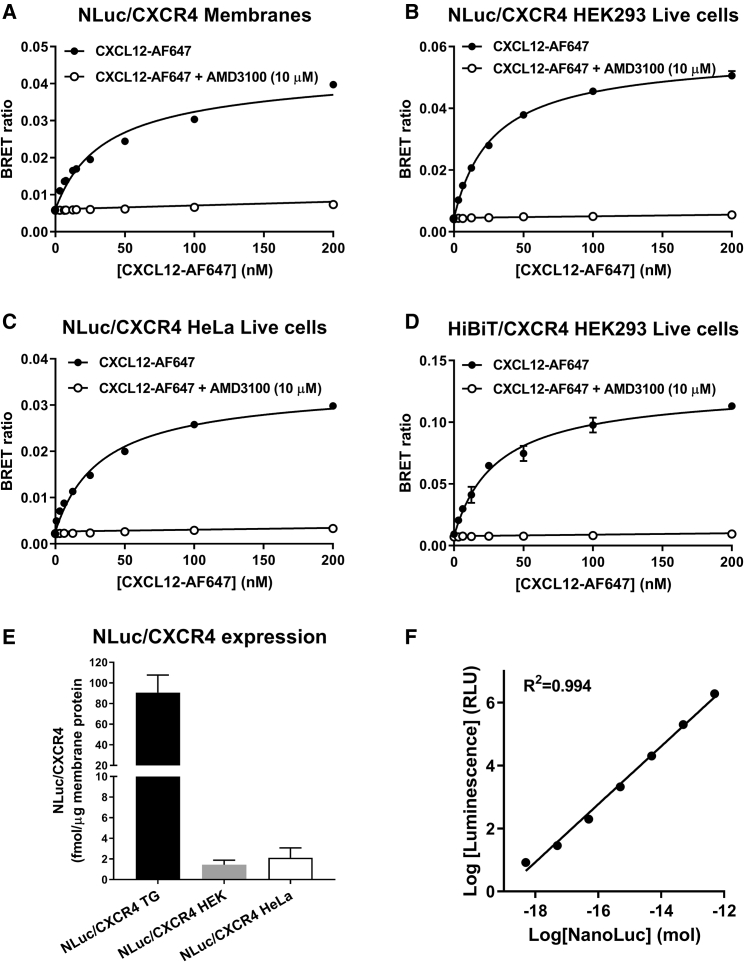
Determination of the Binding Affinity of CXCL12-AF647 at NLuc/CXCR4(A–D) NanoBRET saturation ligand binding curves obtained in (A) membrane preparations from HEK293 cells exogenously expressing NLuc/CXCR4 (B) live HEK293 cells expressing genome-edited NLuc/CXCR4 (C) live HeLa cells expressing genome-edited NLuc/CXCR4 or (D) live HEK293 cells expressing genome-edited HiBiT/CXCR4 complemented with LgBiT. Cells or membranes were incubated with increasing concentrations of CXCL12-AF647 in the absence (black circles) or presence (white circles) of AMD3100 (10 μM) for 1 h at 37°C. Data shown are mean ± SEM and are representative of three or four independent experiments performed in duplicate for (A and B) and (C and D), respectively.(E) Quantification of NLuc/CXCR4 expression by linear regression (F), as described in the STAR Methods, using membrane preparations made from HEK293 cells exogenously expressing NLuc/CXCR4 (NLuc/CXCR4 TG, black bar), HEK293 cells expressing genome-edited NLuc/CXCR4 (NLuc/CXCR4 HEK, gray bar), or HeLa cells expressing genome-edited NLuc/CXCR4 (NLuc/CXCR4 HeLa, white bar).Data shown are (F) mean ± SEM or (E) representative of five individual experiments performed in triplicate (see Figure S2).